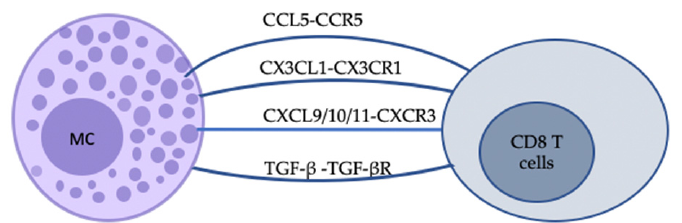
Figure 3. Schematic representation of some of the indirect bidirectional interactions between MCs and CD8 T cells. The communication between MCs and CD8 T cells can be realised by soluble mediators. Chemokine–chemokine ligand interactions can provide instructive signals for CD8 T cells. For example, CCL5-CCR5 and CXCL9/10/11-CXCR3 binding can promote cell migration to Th1-type inflammatory sites, while the latter also plays a role in cell activation and differentiation. TGF- β -TGF- β R signals can promote CD8 T cell residency in skin.